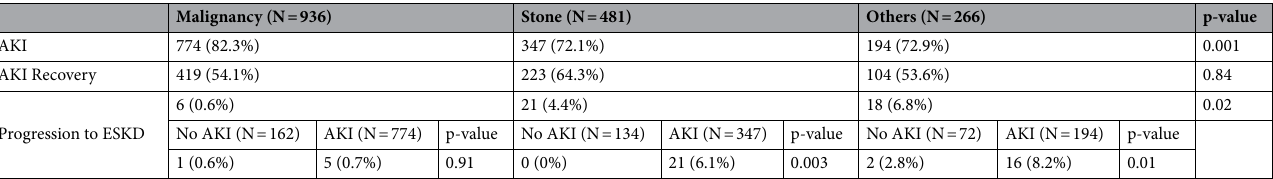
Table 4. Kidney outcomes of obstructive uropathy. AKI acute kidney injury, ESKD end-stage kidney disease.